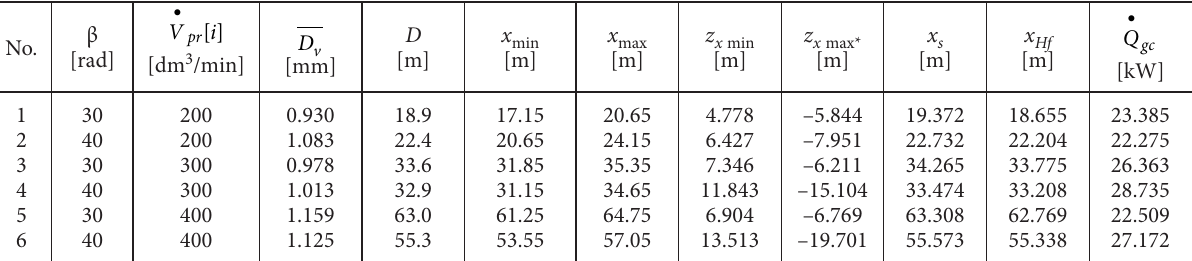
Table 3. Results of simulation